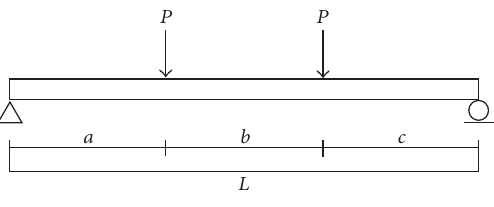
Figure 4: 2-point simply supported